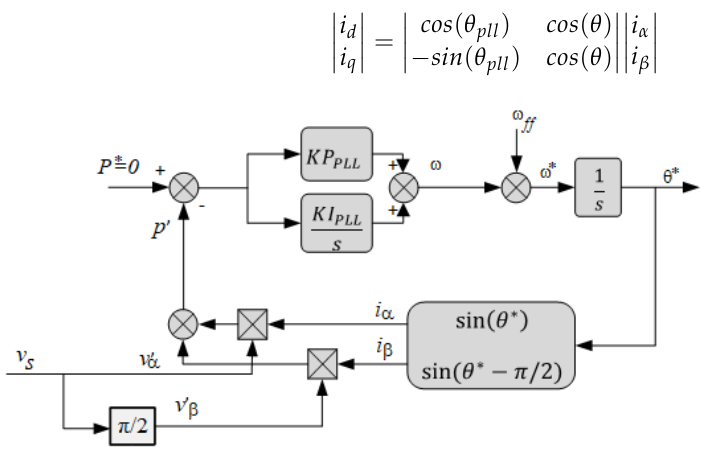
Figure 6. Block diagram of the PLL